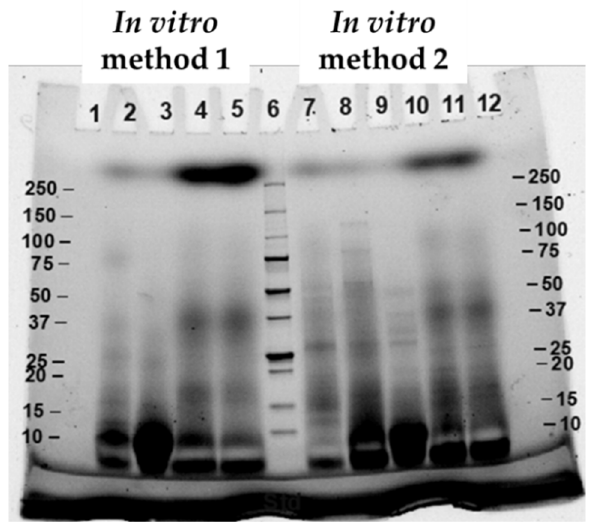
Figure 3. SDS-PAGE of commercial broiler breasts (CB) digested by method 1 (lane 2–5) and method 2 (lane 7–11) and collected at end of oral phase (lane 2 and 7), end of gastric phase (lane 3 and 8), and before (lane 9), half (lane 4 and 10), and end (lane 5 and 11) of intestinal phase. Lane 6 was protein maker.